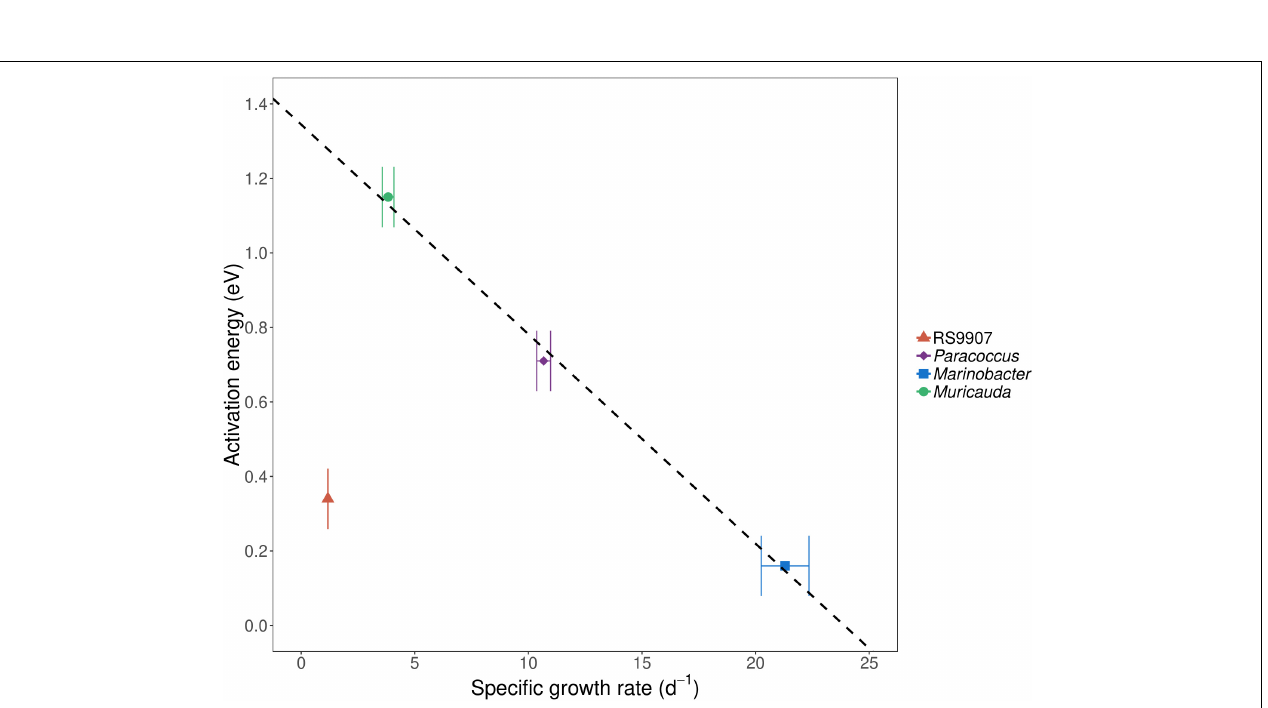
FIGURE 6 | Mean activation energy ( E a ) estimated from specific growth rates for at least three different temperatures (see section Materials and Methods and Figure 5 for details) vs. mean specific growth rate ( µ ) at 28 ◦ C of Synechococcus RS9907, Paracoccus , Marinobacter , and Muricauda in experiment C. Error bars represent standard deviations. The fitted line represents the ordinary least squares linear regression for heterotrophs ( r 2 = 0.99, p = 0.04, n = 3). The activation energy of Marinobacter was estimated from specific growth rates at all tested temperatures (24–34 ◦ C) while Muricauda and Paracoccus were estimated including only temperatures from 24 to 30 ◦ C. For Synechococcus, the activation energy was calculated from specific growth rates from 24 to 33 ◦ C.